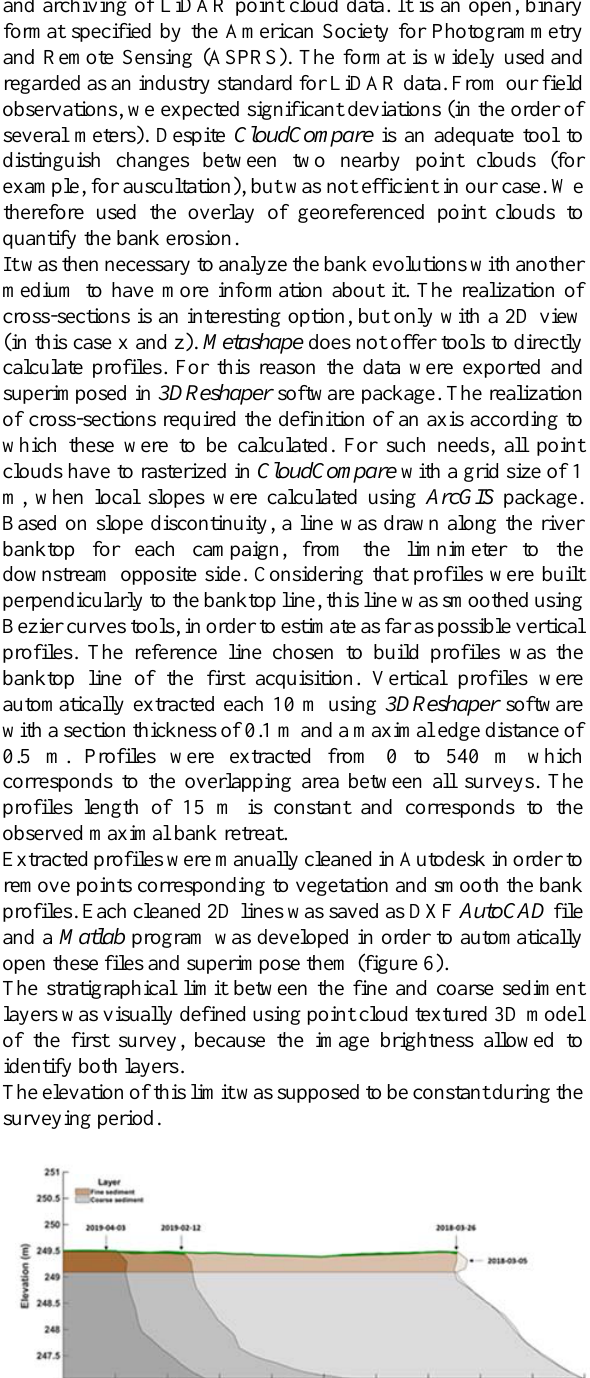
Figure 5: Planimetric evolution of the meander bend during